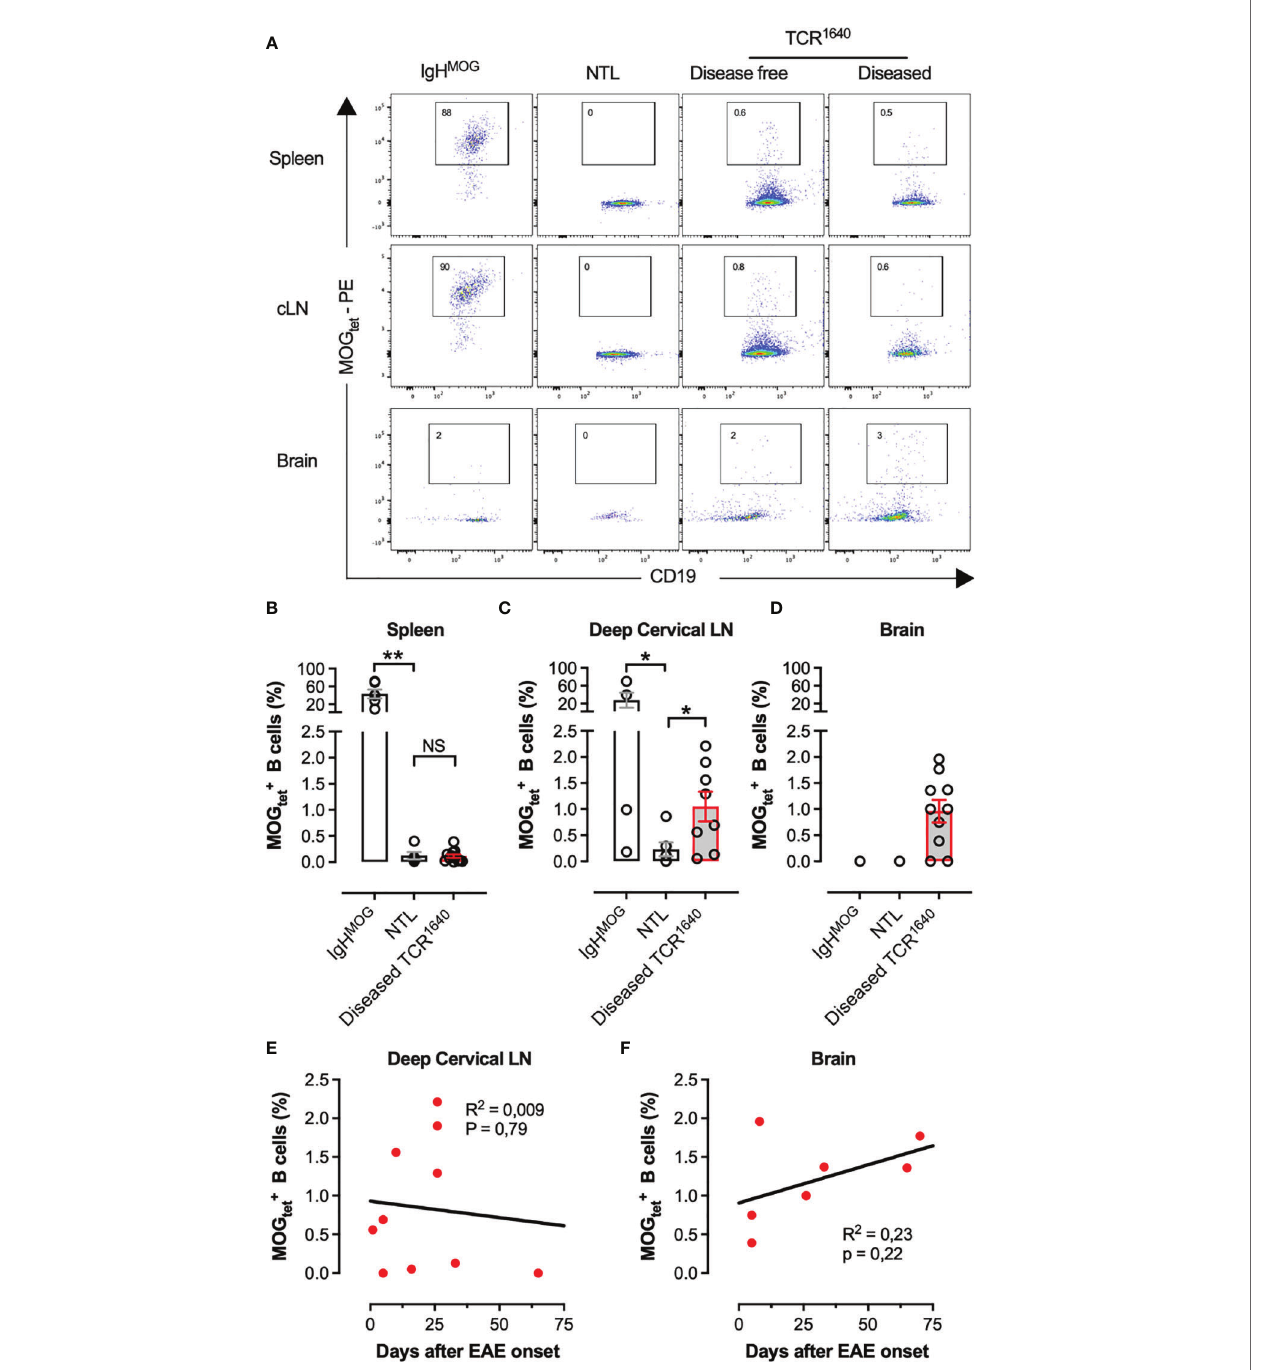
FIGURE 5 | Frequency and localisation of MOG + tet B cells in TCR 1640 mice; (A) A representative fl ow cytometry pro fi le gated on viable CD4 neg CD20 + CD19 + B cells. MOG 1-125 -tetramer staining of single cell populations from the spleen (top row), cervical lymph nodes (middle row), and percoll puri fi ed mononuclear cells from the brain (Bottom row) are presented from IgH MOG mice (Left column), NTL (center left column), disease-free TCR 1640 (center right column) and diseased TCR 1640 mice (right column). Data representative of 3 independent experiments. (B) Precursor frequency of MOG + test B cells in the spleen (IgH MOG n = 6; diseased TCR 1640 n = 12; NTL n = 5), (C) , cervical lymph nodes (IgH MOG n = 4; diseased TCR 1640 n = 8; NTL n = 6), and (D) brain (IgHMOG n = 2; diseased TCR 1640 n = 10; NTL n = 3). The mean frequency of n samples +/- SEM is presented. (E, F) Correlation between the frequency of MOG + test B cells and the delay after EAE onset in deep cervical lymph node (E) or in brain (F) in diseased TCR 1640 mice. Student t-test (B, C) ; Fisher exact for linear regressions (E, F) . NS, Not Signi fi cant; *p < 0.05; **p <